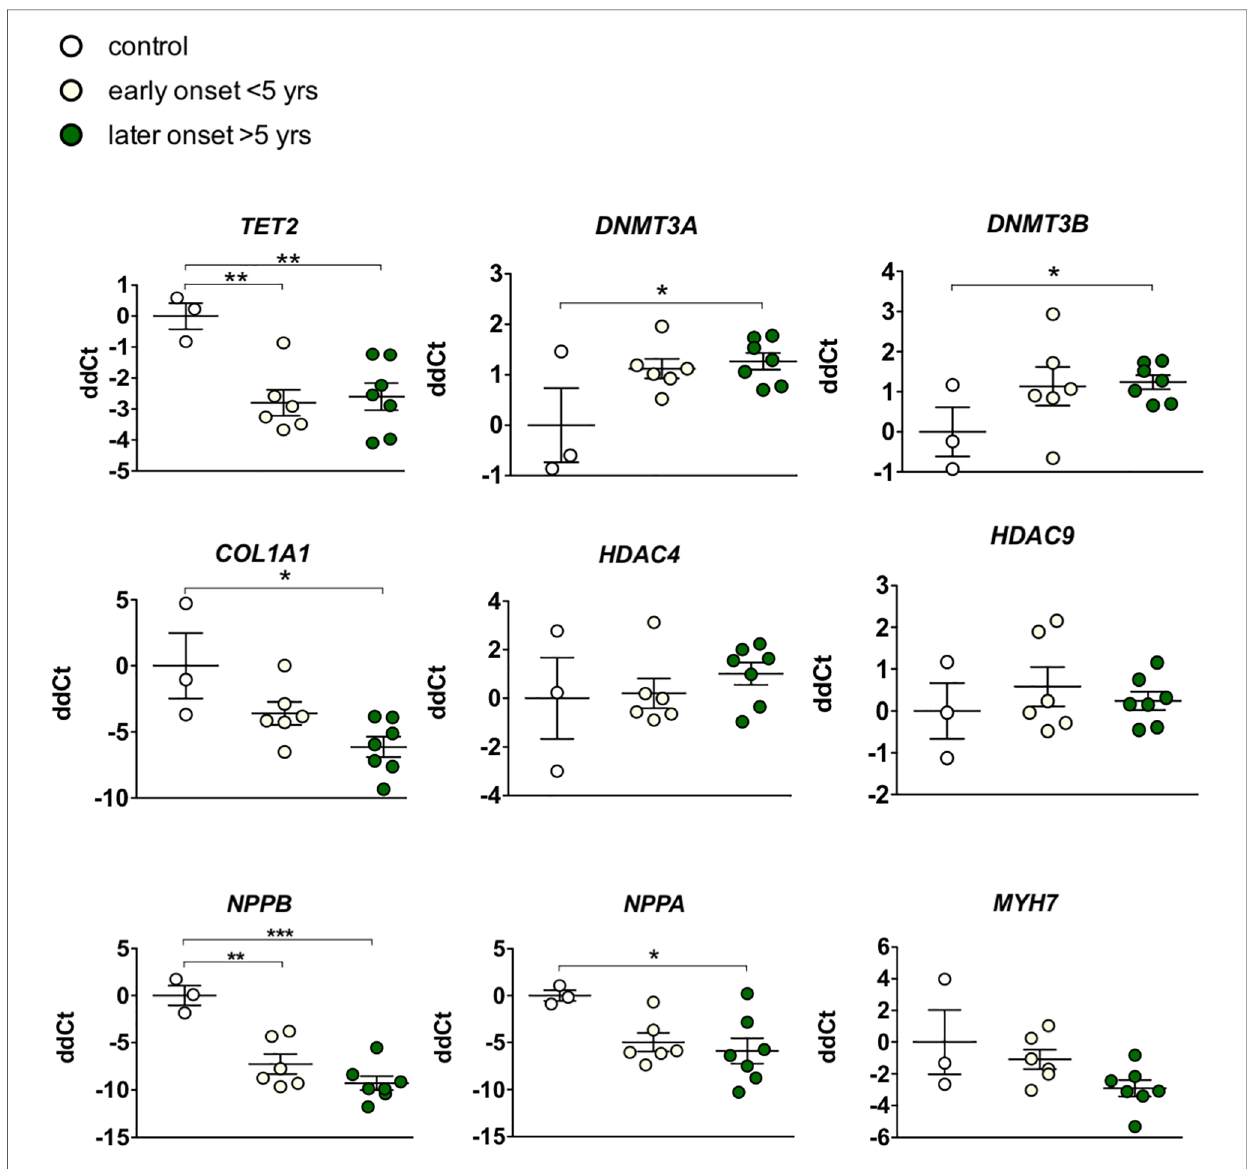
FIGURE 3 Targeted gene expression analysis of epigenetic markers revealed distinct differential regulation of DNA methylation modi fi ers in early vs. late cardiotoxicity in myocardial patient biopsies. Con fi rmation of the upregulation of TET2, and the downregulation of DNMT3A and DNMTB in biopsies of chemotherapy-induced cardiomyopathy patients vs. controls. While COL1A1 was also upregulated in late cardiotoxicity patients, HDAC4/9 and MYH7 were not signi fi cantly affected. As expected in heart failure biopsies, NPPA and NPPB genes were upregulated. * Means p <0.05 in one-way